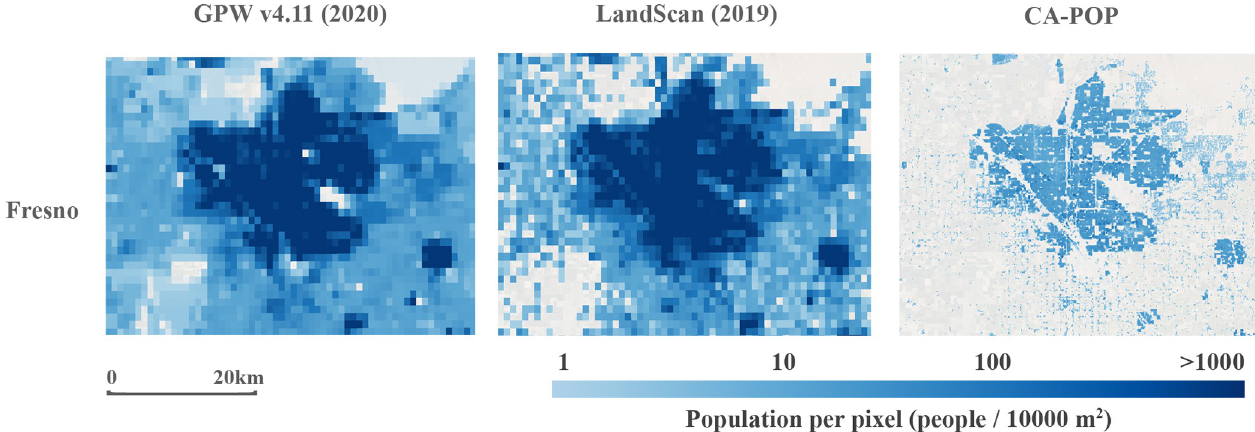
Fig 4. CA-POP compared to the GPW and LS 1km resolution datasets. Examples are shown for the Fresno area, CA. (Satellite base imagery source: USGS (NAIP) from The National Map).